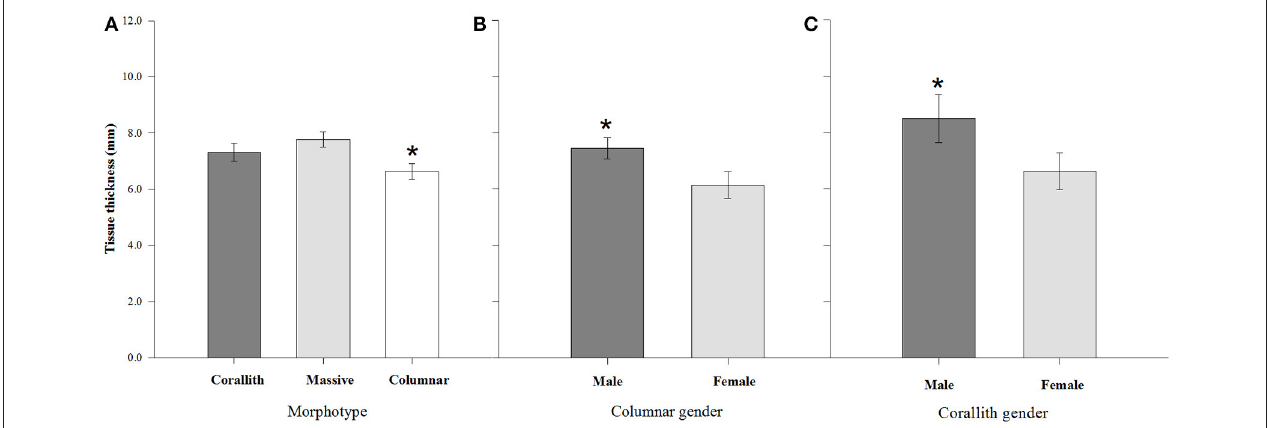
FIGURE 5 | Tissue thickness ( ± 95% confidence limits) differences among morphotypes and the effect of gender (across genders). (A) Comparison between corallith, massive and columnar morphologies. (B) Comparison between genders within the columnar morphotype group. (C) Comparison between genders within the corallith group. * denotes statistically significant difference ( P <